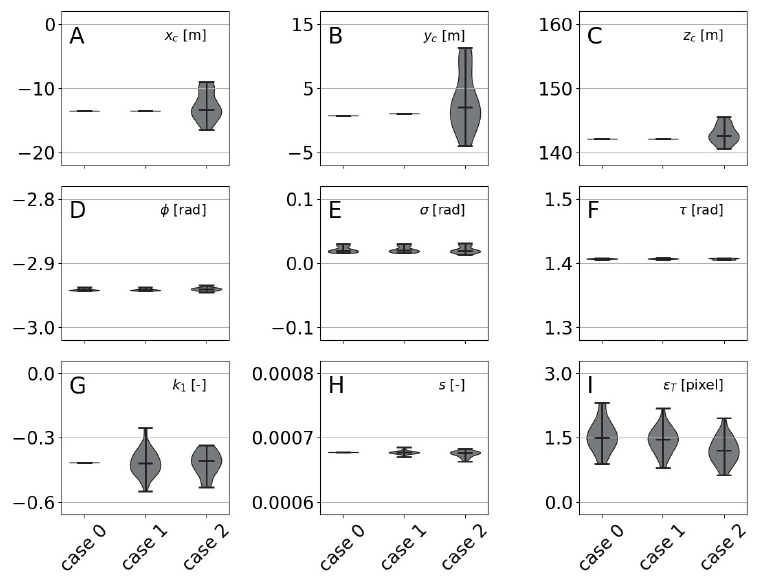
Figure 8. Histograms of the camera position ( A – C ), eulerian angles ( D – F ), intrinsic parameters ( G , H ) and calibration error ( I ) for the calibration of the 24 images of BCN1 basis with n p = 6 and for cases 0, 1 and